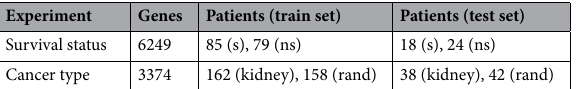
Table 2. Experimental data ( survived, ns non-survived, rand random cancer type).